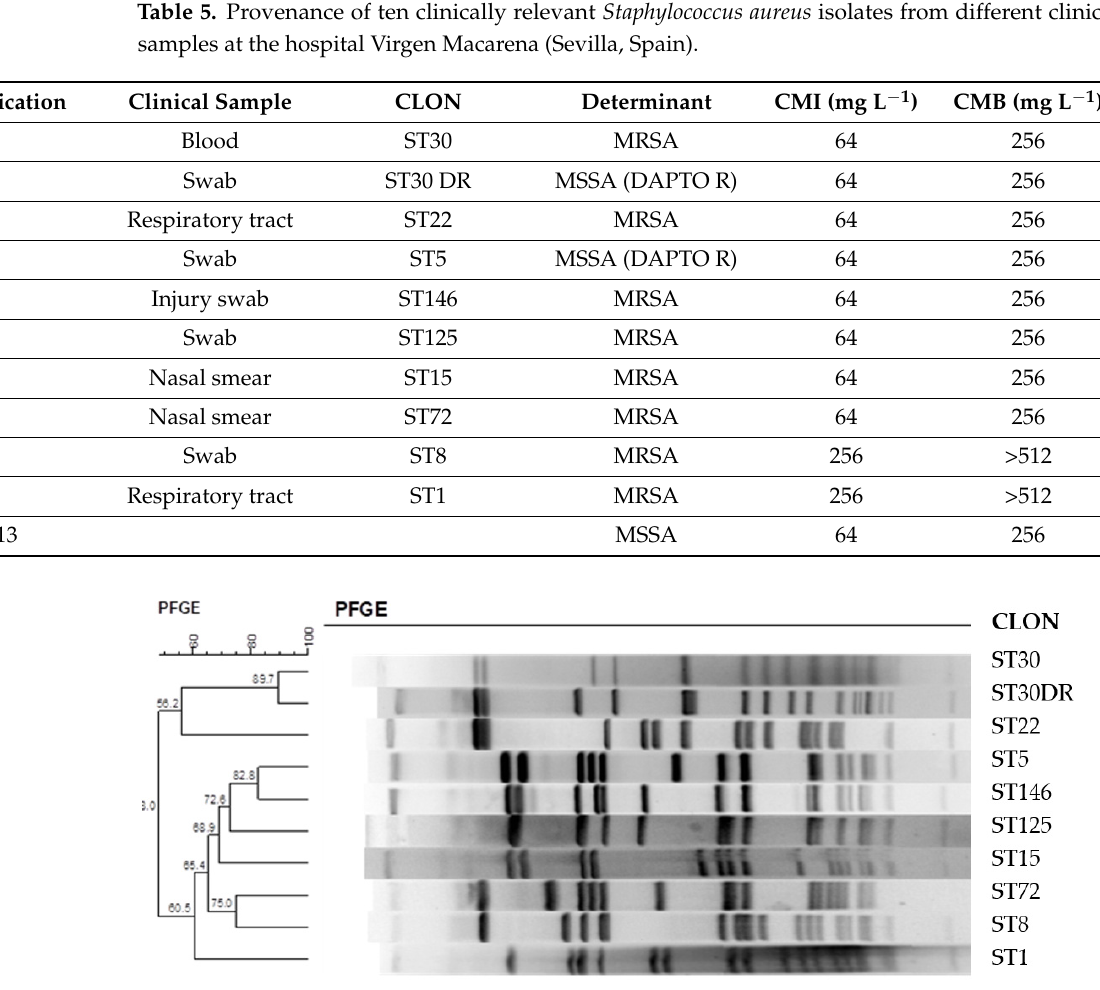
Figure 6. Analysis of the genetic diversity of ten clinically relevant isolates of Staphylococcus aureus by PFGE.